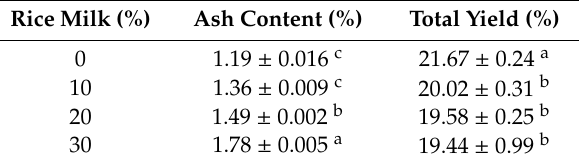
Table 1. Percentage of Ash and total yield of fresh